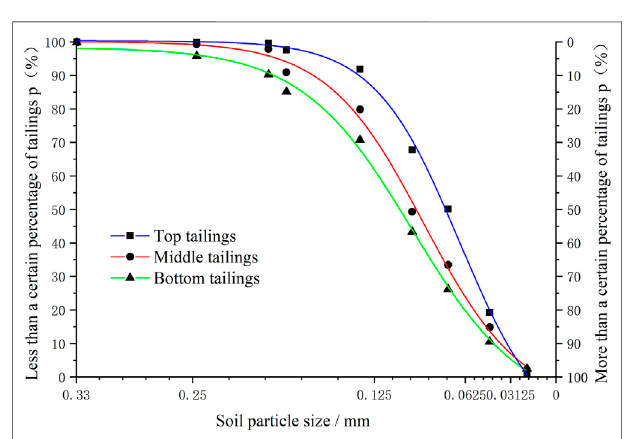
FIGURE 2 | Particle size distribution curve of different sedimentary